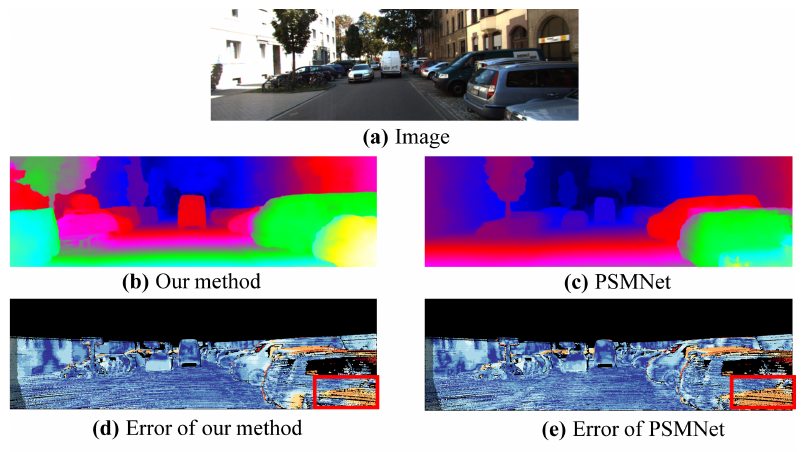
Figure 11. Illustration of the effect on the continuous region in an example from KITTI 2015. ( a ) is the original image, ( b ) is the result of our method, ( c ) is the result of baseline model, ( d ) is the disparity error map of our method and ( e ) is the error map of baseline